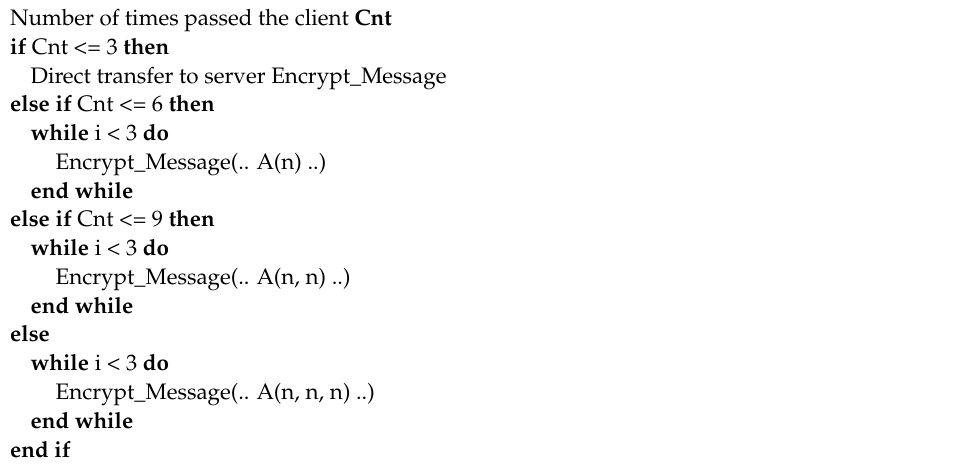
Algorithm 1. Transmission method according to the number of